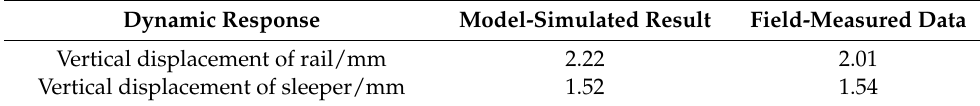
Figure 6. Illustration of two different subgrade configurations used for verifying the numerical model developed: ( a ) Case 1—Heavy-haul railway and ( b ) Case 2—High-speed railway. Table 1. Comparison of model-simulated results and field-measured